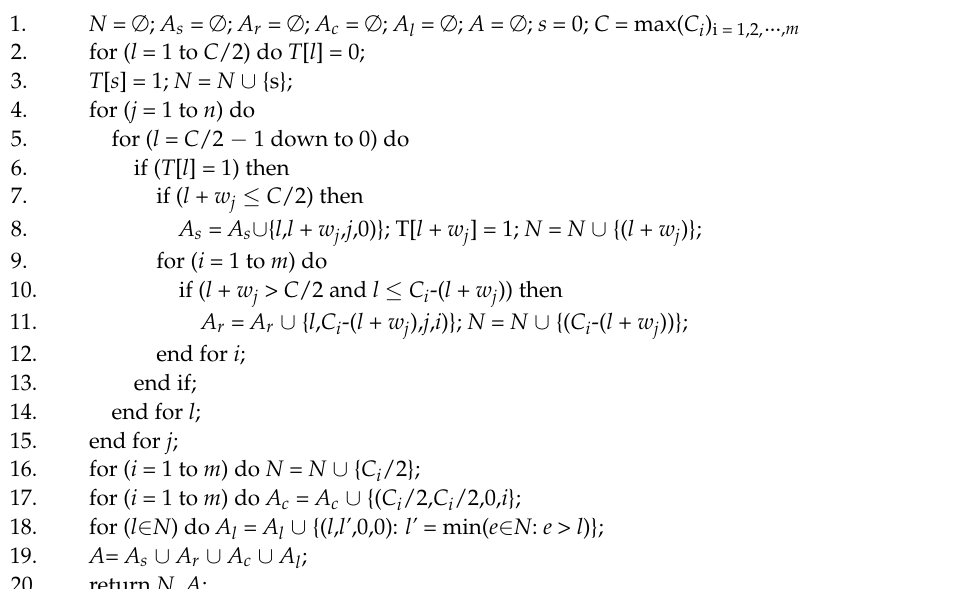
Algorithm 6: Create-reflect-multigraph-MKP in O( mnC